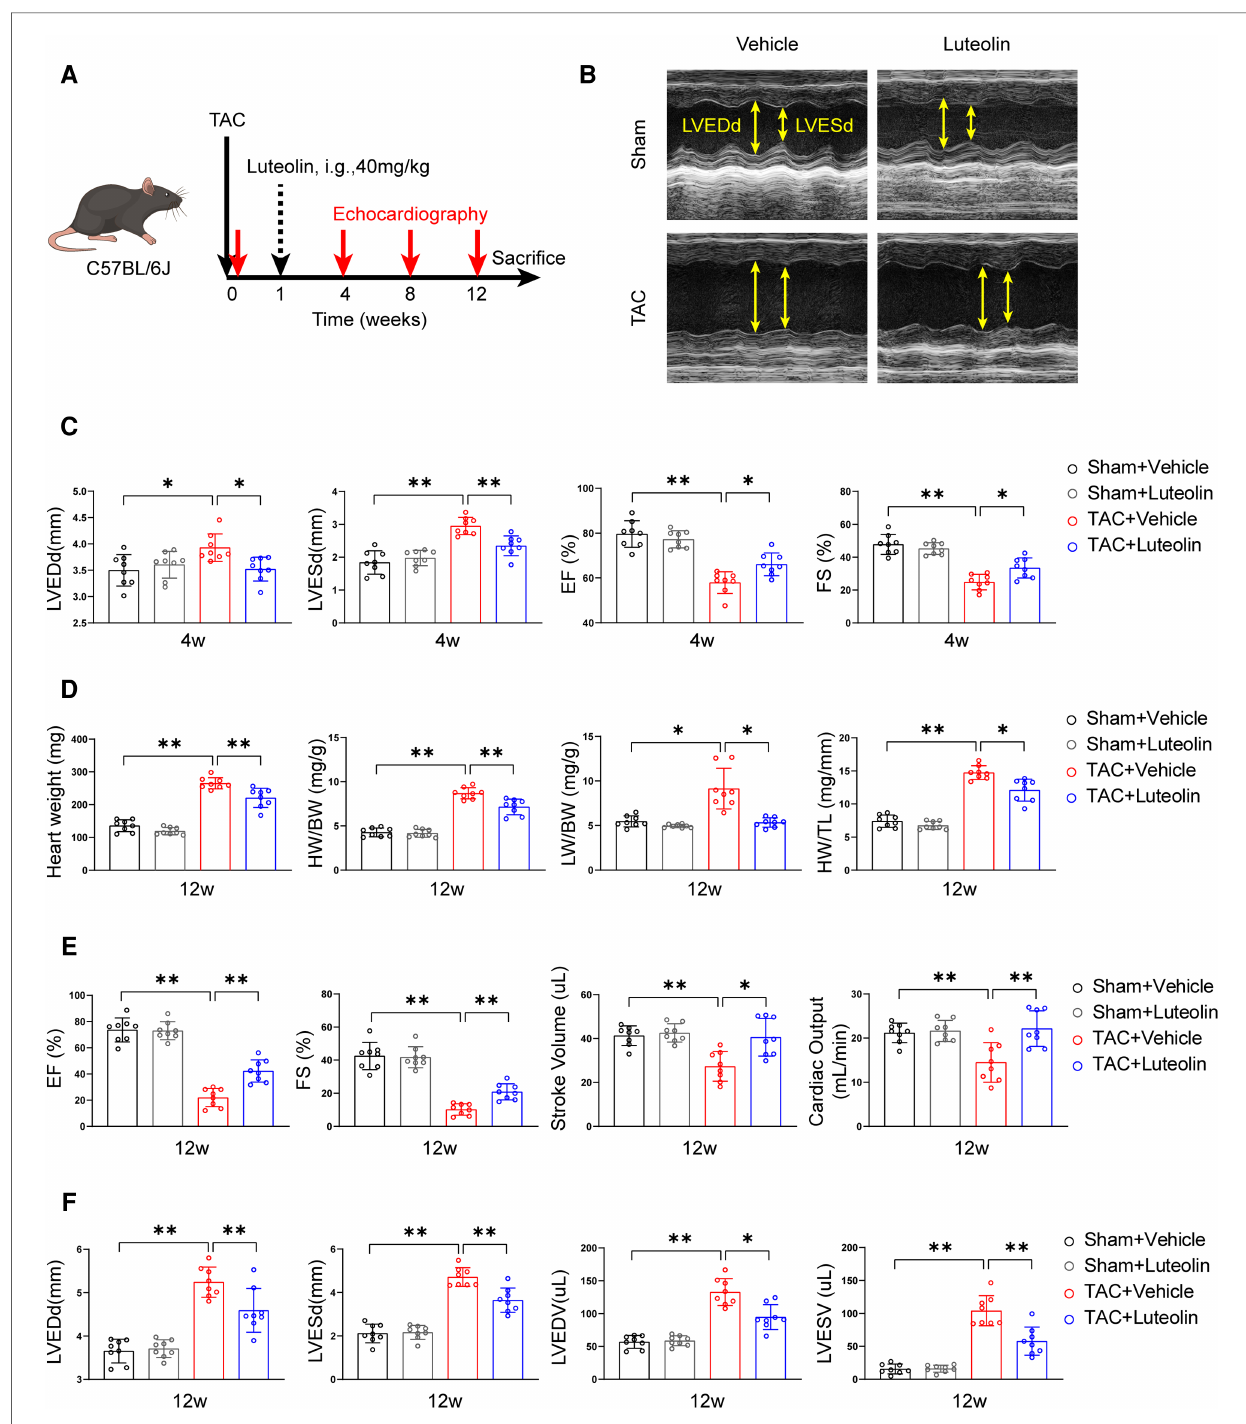
FIGURE 3 Luteolin inhibits cardiac dysfunction induced by pressure overload in mice. ( A ) Schematic diagram of the experimental procedure. ( B ) Representative echocardiography images of mice measured at 12 weeks after TAC. ( C ) Assessments of echocardiographic parameters of left ventricular end-diastolic diameter (LVEDd), left ventricular end-systolic diameter (LVESd), ejection fractions (EF), and fraction shortening (FS) of mice at 4 weeks after sham or TAC surgery ( n =8). ( D ) Heart weight (HW), HW/body weight (BW), lung weight (LW)/BW, and HW/tibia length (TL) ratios of mice at 12 weeks after sham or TAC surgery ( n =8). ( E,F ) Assessments of echocardiographic parameters of EF, FS, stroke volume, cardiac output, LVEDd, LVESd, left ventricular end-diastolic volume (LVEDV), and left ventricular end-systolic volume (LVESV) of mice at 12 weeks after sham or TAC surgery ( n =8). Values are presented as mean±SD. * P <0.05, ** P